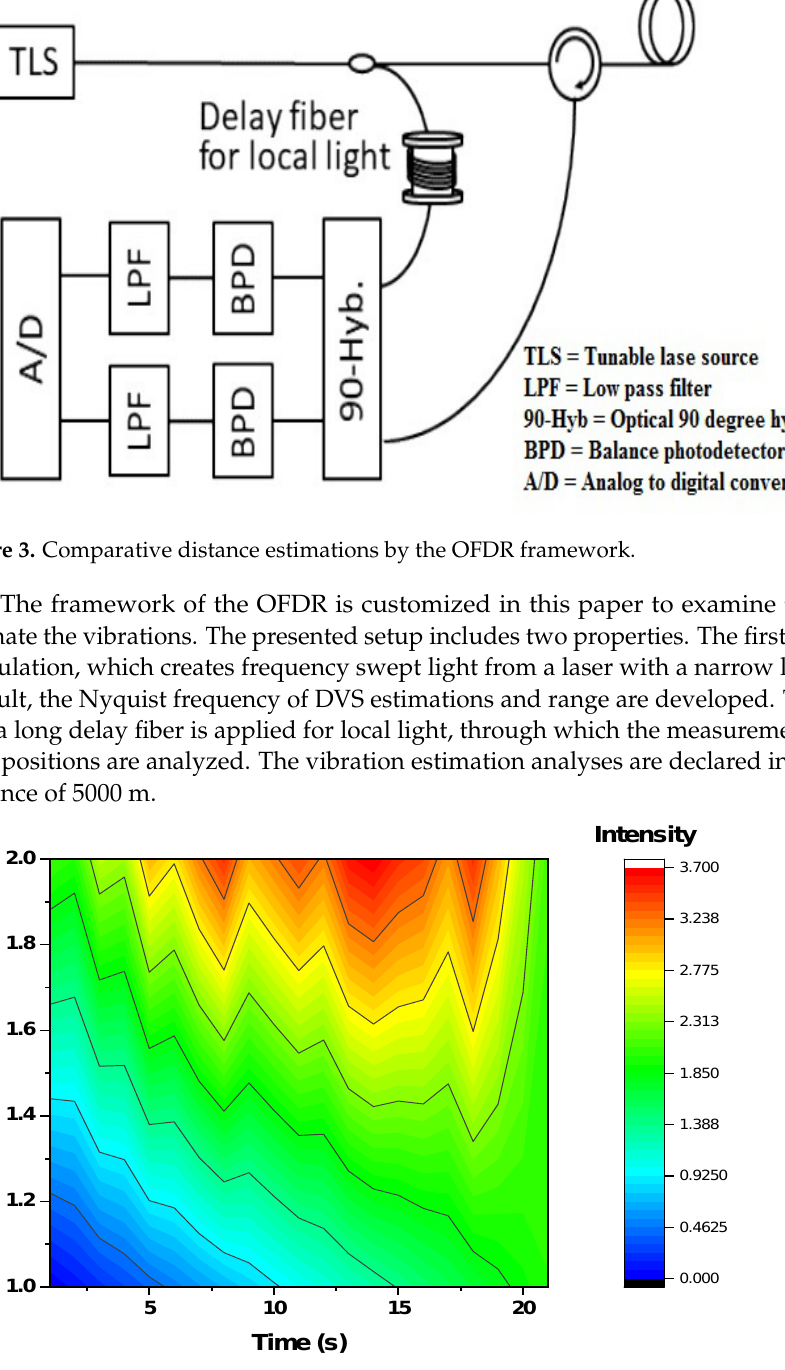
Figure 4. Optical frequency measurement in terms of time at 5000 m. fiber